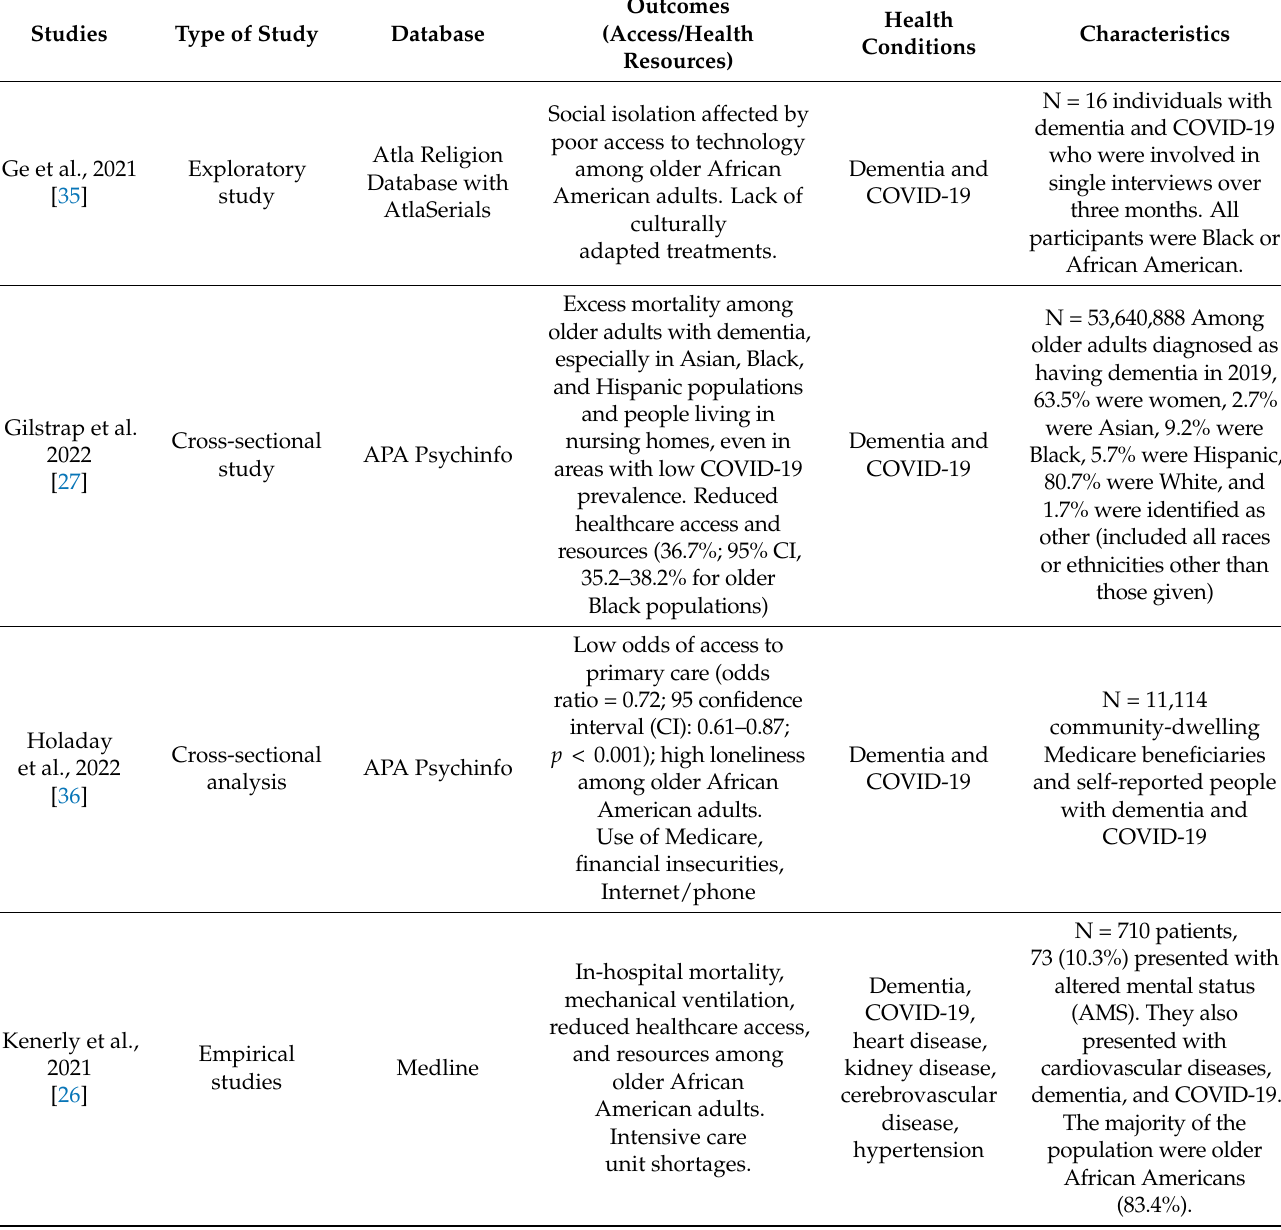
Table 2. Summary of study participants and their characteristics of the included